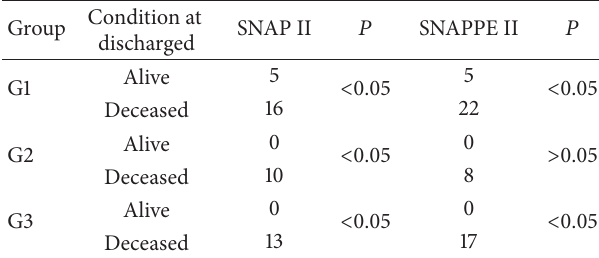
Table 3: Median of SNAP II and SNAPPE II score of the three groups and the condition at discharge.